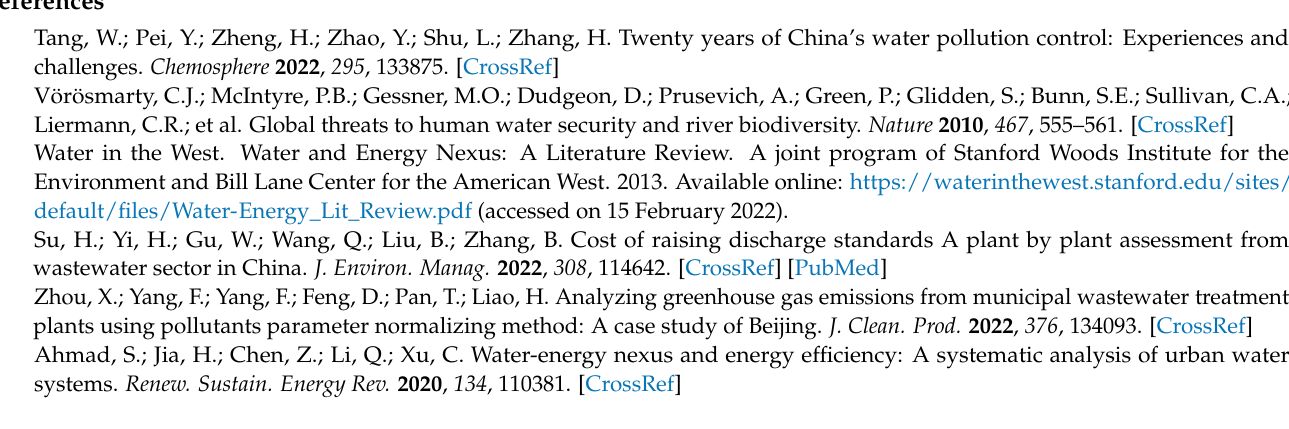
Table S2: Representative policies related to wastewater governance at the national and municipal levels; Table S3: Local standards of wastewater treatment and reuse in